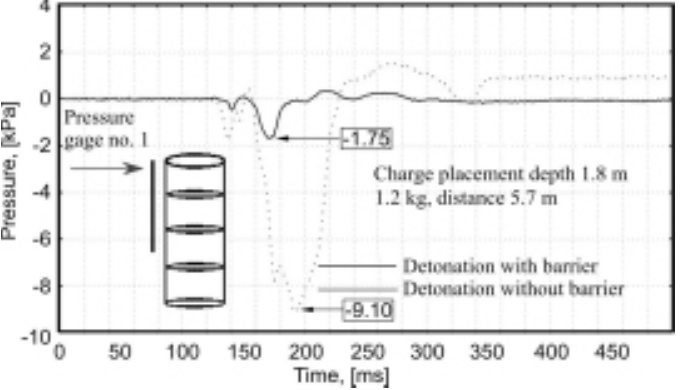
Fig. 11. Time histories of pressures p h on the structure front, measured by gage No. 1 from a detonation at 5.7 m from the silo. The data registered by pressure gage No. 1 at the top of the front structure (Figs 10 ÷ 13), indicate that the attenuation coefficients C t, obtained from Eq. (4), for the distances 7.0 m, 5.7 m, 4.7 m, and 3.7 m are equal to 0.23, 0.19, 0.52, and 0.78, respectively. As can be seen, the coefficients for distances of 7.0 m (shot No. 1)